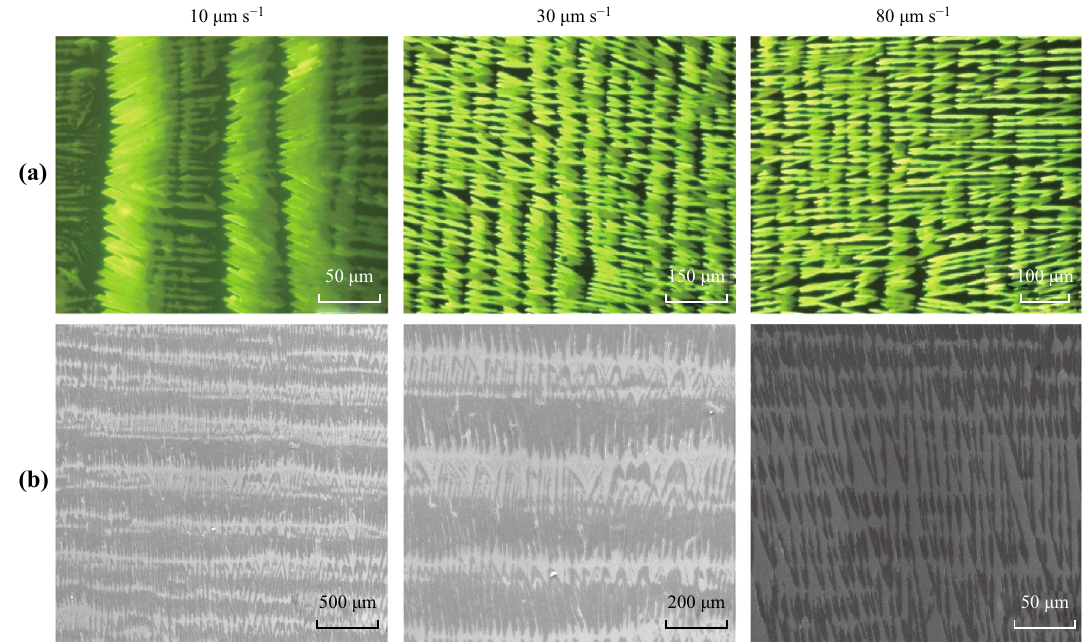
Fig. 3 Fluorescence microscope images ( a ) and the corresponding SEM images ( b ) of BPEA nanoribbon arrays on the SiO 2 /Si substrate formed at coating speeds of 10, 30, and 80 l m s - 1 ,